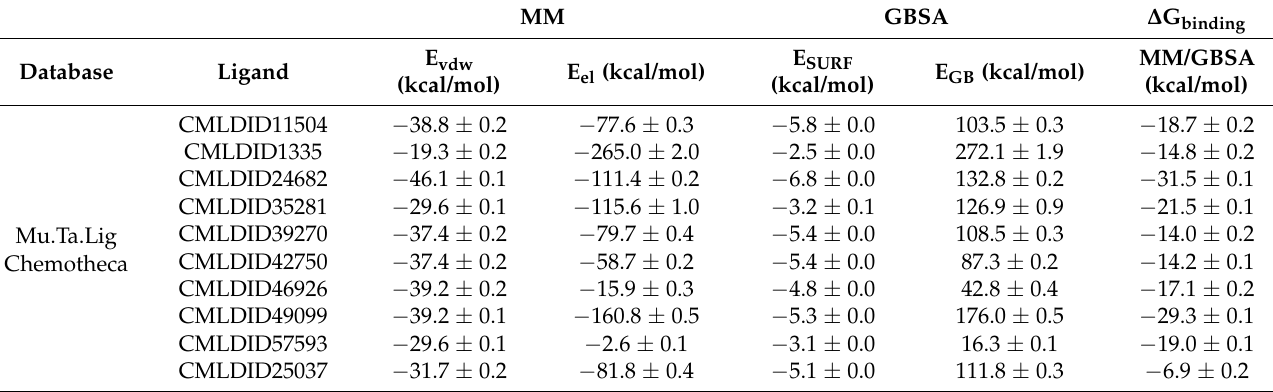
Table 5. Results for the MM/GBSA calculations on the selected molecules and all their